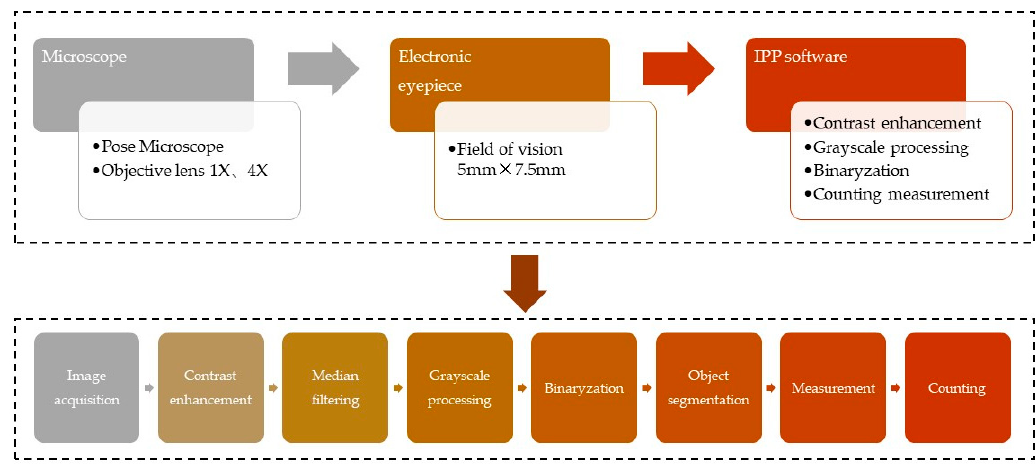
Figure 4. Image acquisition and analysis process.